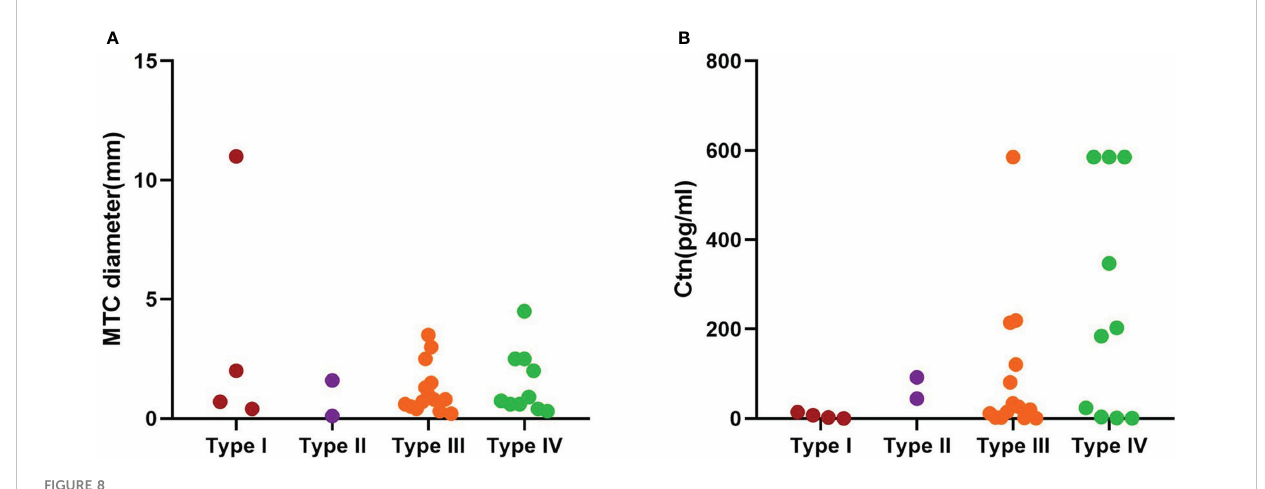
FIGURE 8 MTC tumor diameter and Ctn in each subtype. (A) MTC tumor diameter; (B)